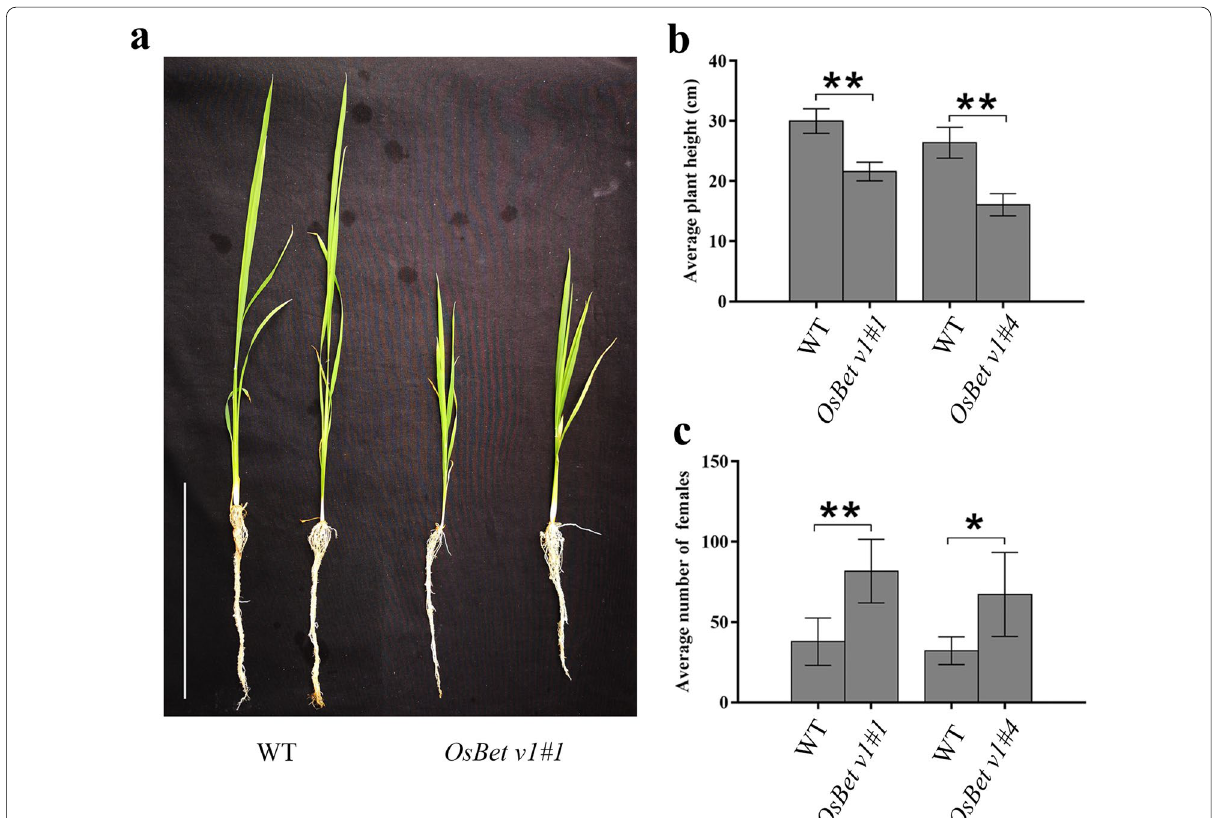
Fig. 6 Growth phenotypes of ‘transgene-free’ OsBet v1 knockout mutants and their susceptibility to Meloidogyne graminicola . a , b Plant height of the wild-type (WT) and OsBet v1 knockout mutants in potting experiment at 14 days after germination. Scale bar: 20 cm. c The average number of females in indicated rice lines at 14 days post-inoculation (dpi) with M. graminicola . Each experiment was performed two times. Data are presented as the mean SD. * P < 0.05, ** P < 0.01, Student’s t -test ±